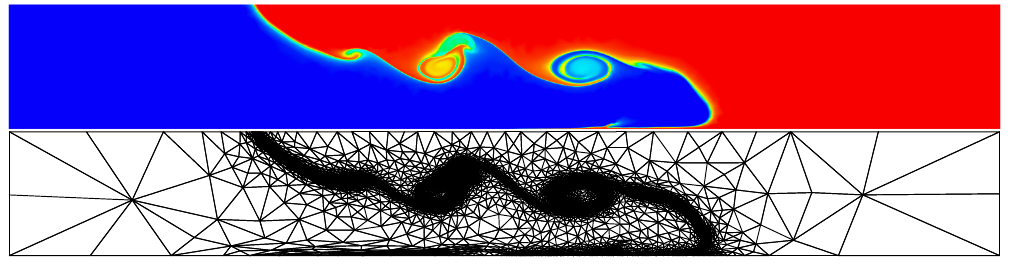
Fig. 6. Top: the temperature field for the lock exchange problem at time 14.2s. It is apparent that diagnosing the head location from density contours is straightforward. Bottom: the adapted mesh at this time level with enhanced resolution being used to minimise numerical dissipation and maintain a sharp interface between the two density classes in this